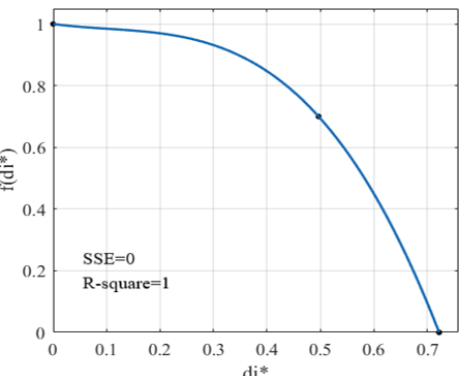
) . d ∗ and f (d ∗ is the relative dis- i i i as the independent i